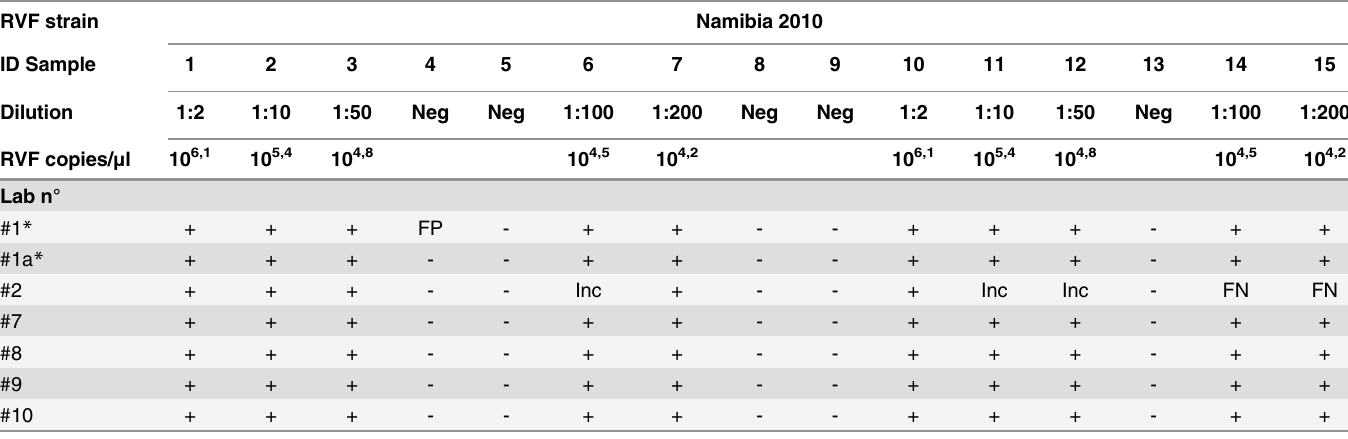
Neg: RVFV seronegative bovine serum. + / -: samples identi fi ed as positive or negative by the participants. FP: false positive result. FN: false negative result. Inc: Inconclusive